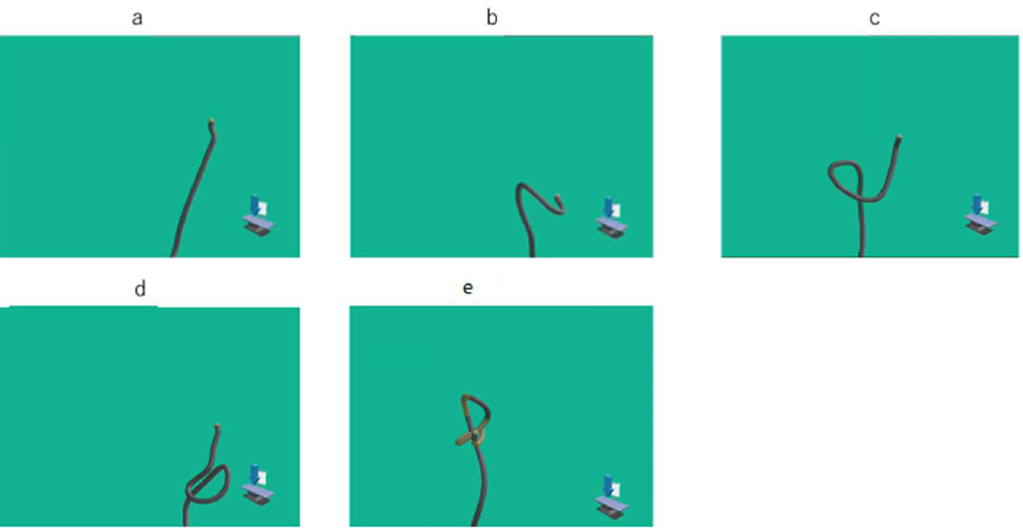
Figure 2. Endoscopic position detection unit (UPD) graphic image of patterns for passing through the sigmoid/descending colon junction: ( a ) straight; ( b ) N-loop; ( c ) α-loop; ( d ) reverse α-loop; ( e ) other.